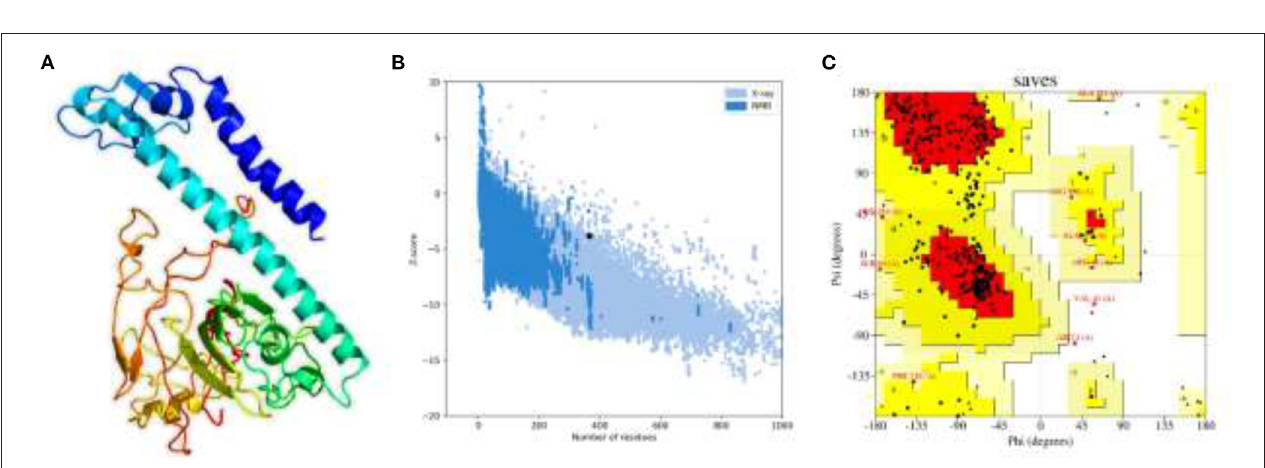
FIGURE 3 | The 3D structural model and validation of the final multi-epitopes-based vaccine design against A. xylosoxidans . (A) The Robetta generated 3D model of the vaccine construct, (B) the ProSA-web that generated a Z-score graph, and (C) the PROCHECK-generated Ramachandran-plot for validation of the structure.